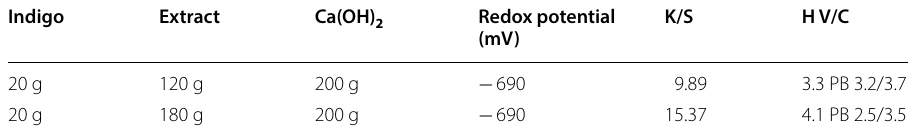
Table 2 Scale-up dyeing using persimmon peel extract (6L, 1.5yd of ramie fabric)